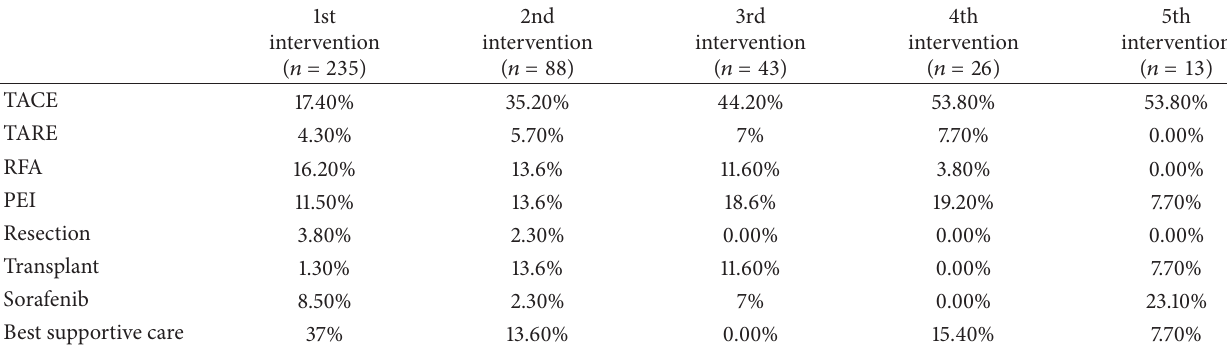
Table 4: Intervention modalities at different stages.